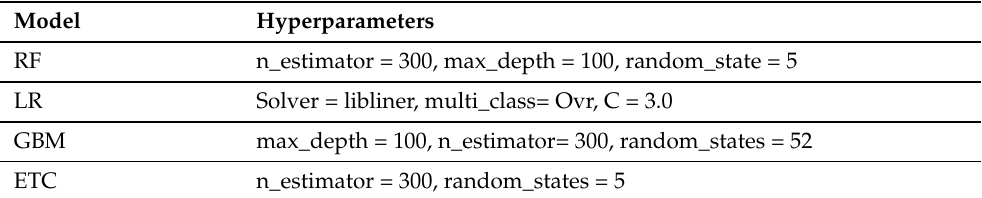
Table 5. Hyperparameters for the models.